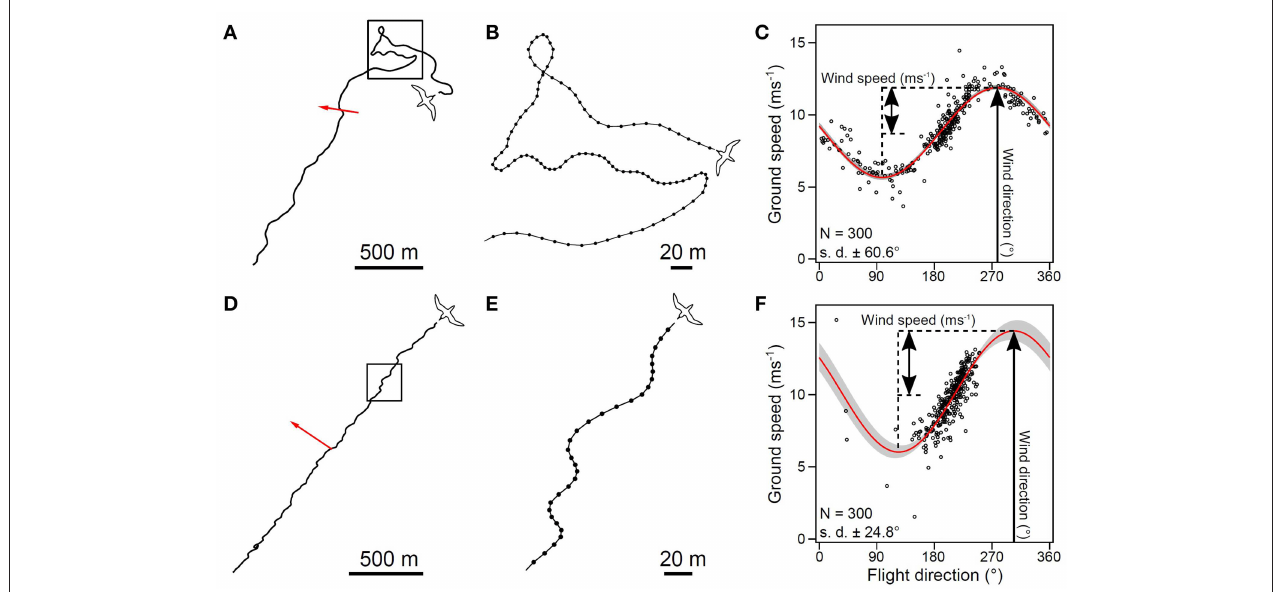
FIGURE 4 | (A) An example of a 5-min section of the flight path of a streaked shearwater. The red arrow indicates the estimated wind velocity. (B) Enlarged view of a meandering path shown in (A) . (D) Another example of a 5-min section of a flight path of a streaked shearwater when the bird seemed to travel in a certain direction. (E) Enlarged view of (D) showing repeated zigzag movement from a soaring maneuver. (C,F) The relationship between flight direction and ground speed of the path section in (A) [estimated wind speed of fitted curve, 3.11m s − 1 ; upper confidence interval (CI), 3.13m s − 1 ; and lower CI, 3.10m s s − 1 ; estimated wind direction of fitted curve, 278 ◦ ; upper CI, 280 ◦ ; and lower CI, 277 ◦ ] and D (estimated wind speed of fitted curve, 4.20 s − 1 ; upper CI, 4.34 s − 1 ; and lower CI, 4.10 s − 1 ; estimated wind direction of fitted curve, 304 ◦ ; upper CI, 310 ◦ ; and lower CI, 298 ◦ ), respectively. Angular SDs of the flight direction are (C) 60.6 ◦ and (F) 24.8 ◦ , respectively. The red curve is the fitted sinusoidal curve. Gray area represents the 95% CI of the fitted sinusoidal curve. Estimated wind speed and direction is indicated by black arrows. The figures adapted from data presented in Yonehara et al.